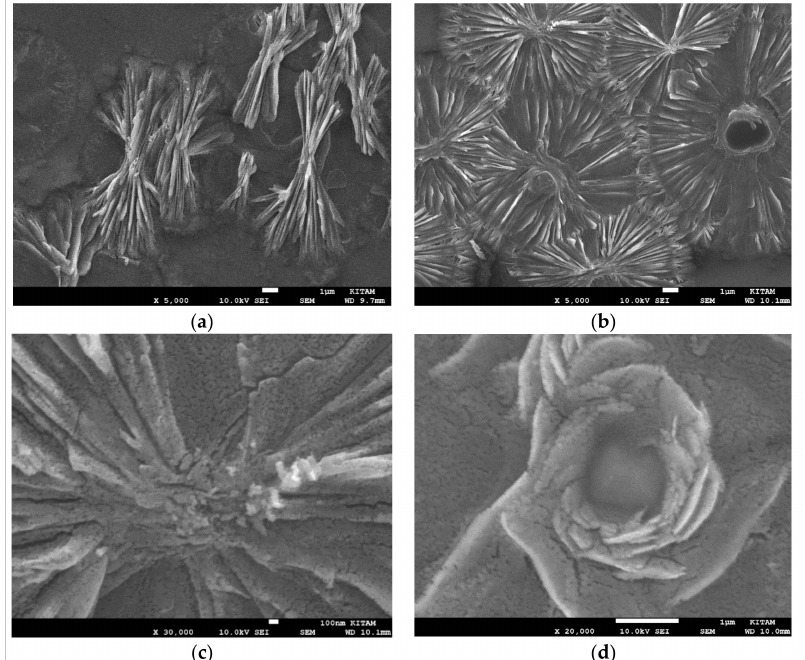
Figure 33. SEM images of the Cu / Si based catalysts showing the Cu-rich structure formation due to phase separation; ( a ) Cu / Si = 1 / 4 catalyst; ( b ) Co / Cu / Si = 1 / 1 / 8 binary catalyst with Cu-rich decorations; ( c ) Co / Cu / Si = 1 / 1 / 8 binary catalyst showing the fine structure of the Cu-rich decorations; ( d ) Co / Cu / Si = 1 / 1 / 8 binary catalyst showing the presence of nano-structure of the decorations in the form of fused particles forming planes with size ca. 30 nm. Scale bar = 1 µ m ( a , b , d ); scale bar = 100 nm ( c